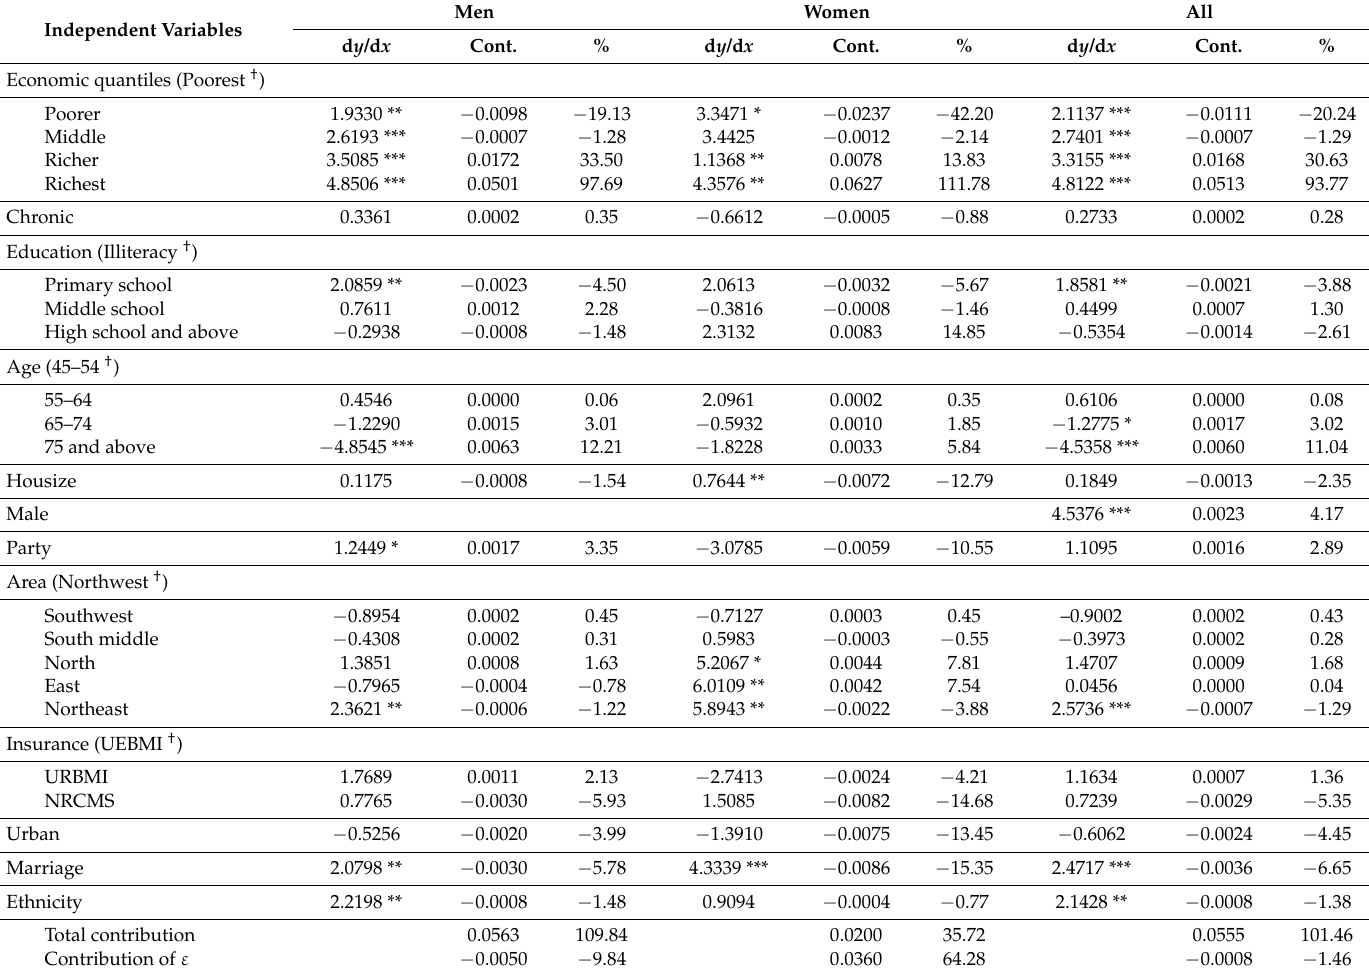
Table 5. Decomposition of concentration index of tobacco use quantities in smokers